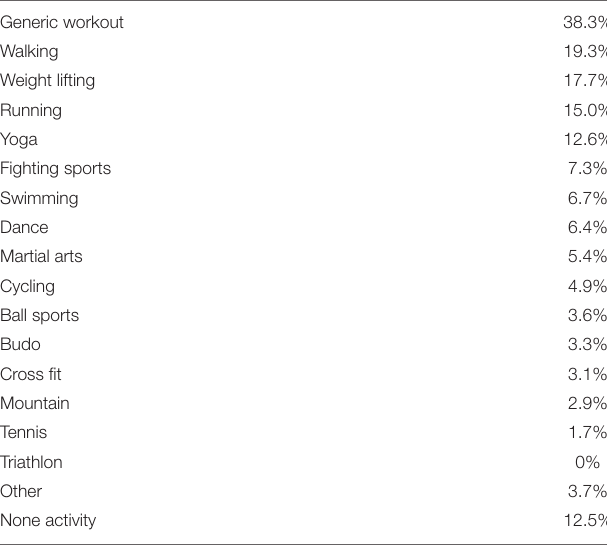
TABLE 1 | Type of activities ( N =